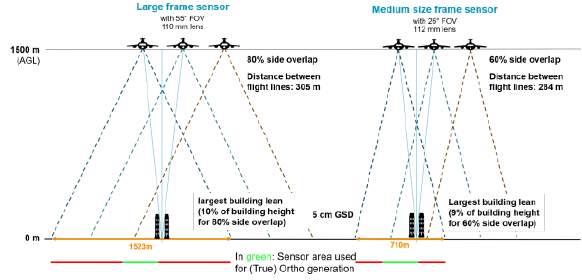
Figure 6: Building Lean vs. Side-Overlap, preferred configuration for TrueOrtho production